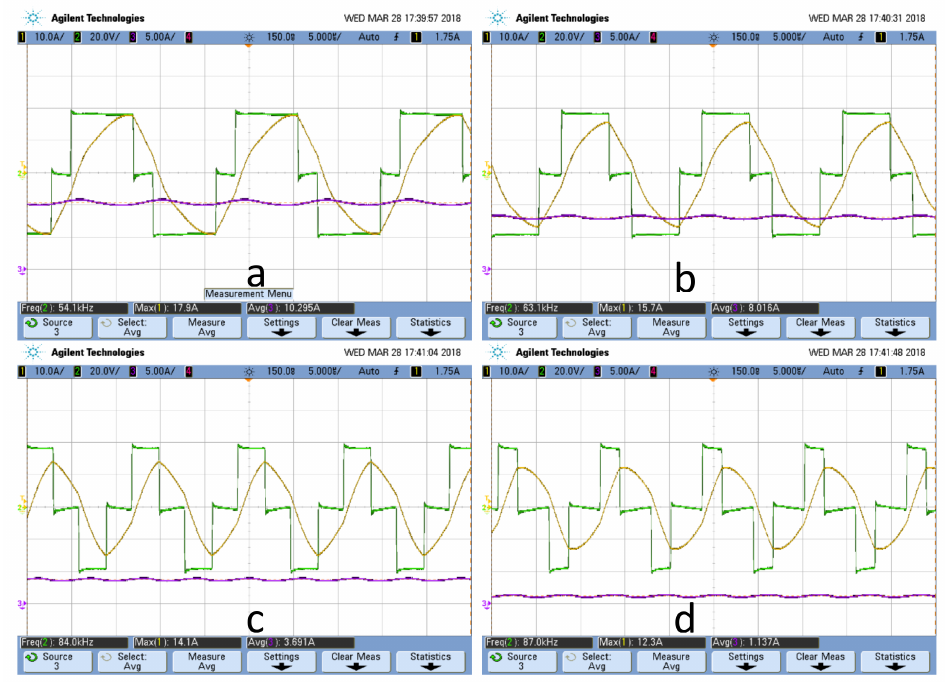
Figure 12. Different output current values, obtained with different frequency/duty cycle values (battery 6S 16,000 mAh 20 C), ( a ) 54.1 KHz; ( b ) 63.1 KHz; ( c ) 84 KHz; ( d ) 87